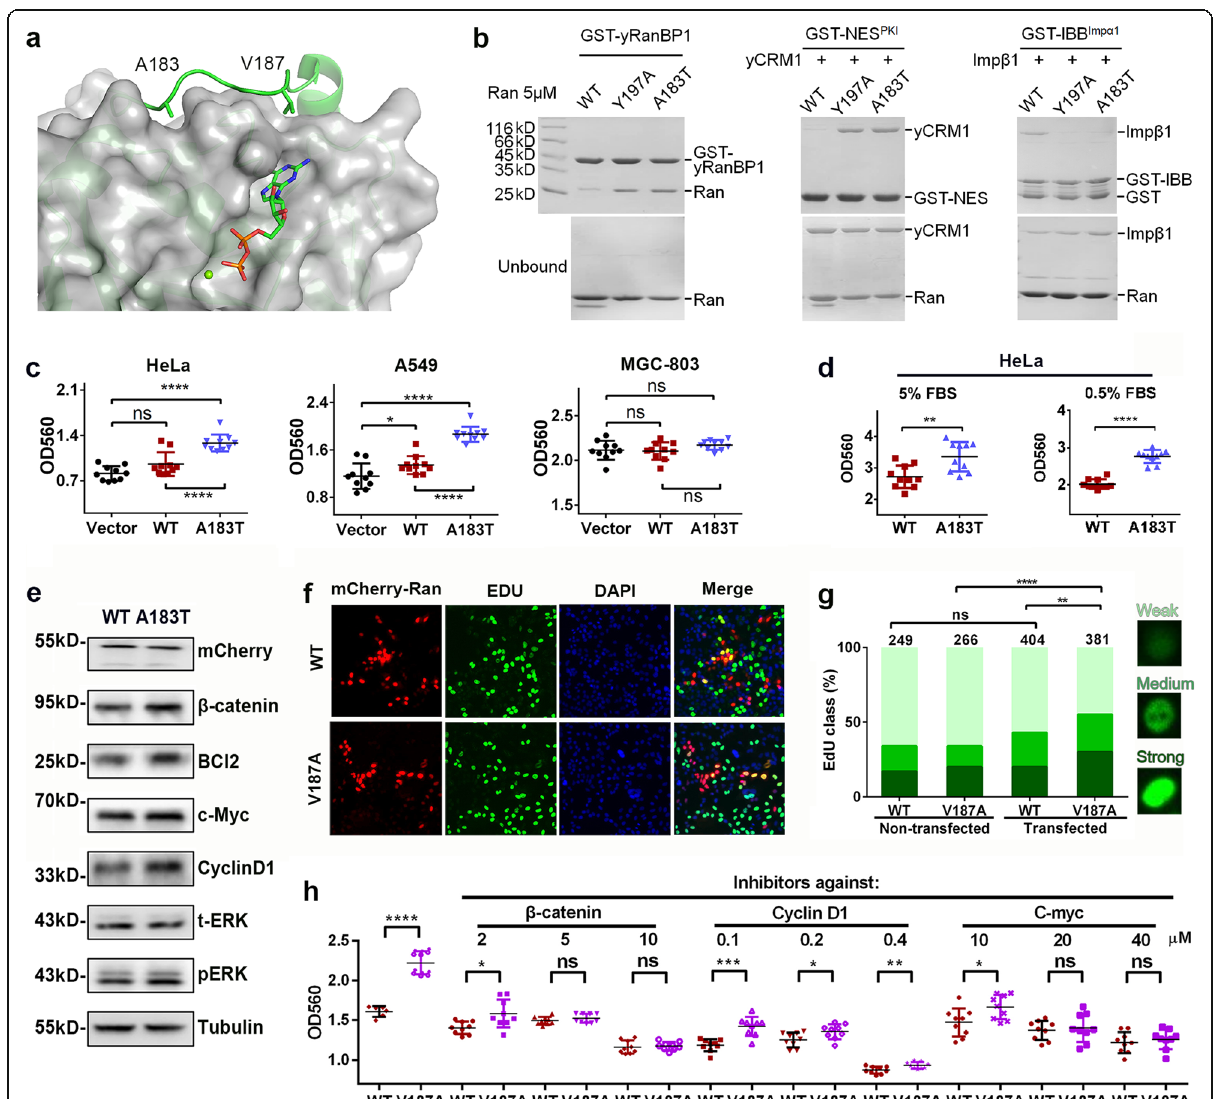
Fig. 6 Enhanced cell proliferation by Ran A183T and Ran V187A . a The interaction between the G domain and two C-terminal residues. b Comparing freshly purified Ran WT , Ran A183T with Ran Y197A binding activity by pull-down. Left: GST-yRanBP1 (yeast RanBP1) pull-down of Ran WT , Ran Y197A , and Ran A183T . Middle and right: GST-NES PKI or GST-IBB Imp α 1 pull-down of yCRM1 or Imp β 1 in the presence of Ran WT , Ran Y197A and Ran A183T . c OD of transiently transfected (~ 50% efficiency) HeLa, A549, and MGC-803 cells respectively using SRB staining. Each transfection was performed with 12 replicates. d The normalized cell density of HeLa stable cell lines expressing mCherry-tagged Ran WT or Ran A183T in the presence of 0.5% or 5% FBS (fetal bovine serum). Y-axis shows the cell density at 72 h normalized by its density at 12 h. e Western analysis of mCherry-Ran stable cell lines (HeLa) grown at 0.5% FBS. f EdU staining of mCherry-WT or mCherry-Ran V187A transiently transfected Hela cells. After three days of transfection, 10 μ M EdU was added in the medium and incubated for 2 h. g Statistical analysis of the EdU staining results. ‘ Non-transfected ’ means the cells that were not showing mCherry signals in the wells of WT or V187A transfection. The numbers shown on top of the bar represent the total number of cells analyzed for each group. Statistical significance between groups was calculated by treating strong, medium, and weak EdU cells as 1, 2, 3, respectively. h The cell density of mCherry-WT or mCherry-V187A transfected HeLa in the presence of different inhibitors. Concentrations of 10,058-F4, Fascaplysin, and Nitazoxanide are shown in the